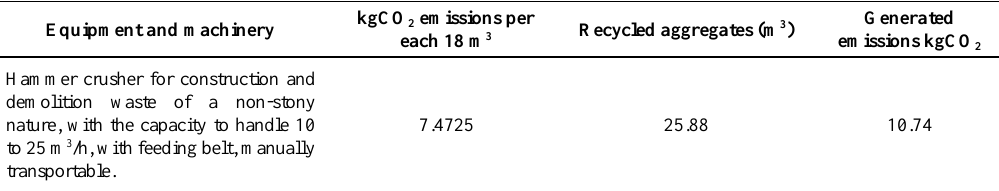
Table 9. CO 2 emissions of equipment and machinery for the recycling of CDW (Case